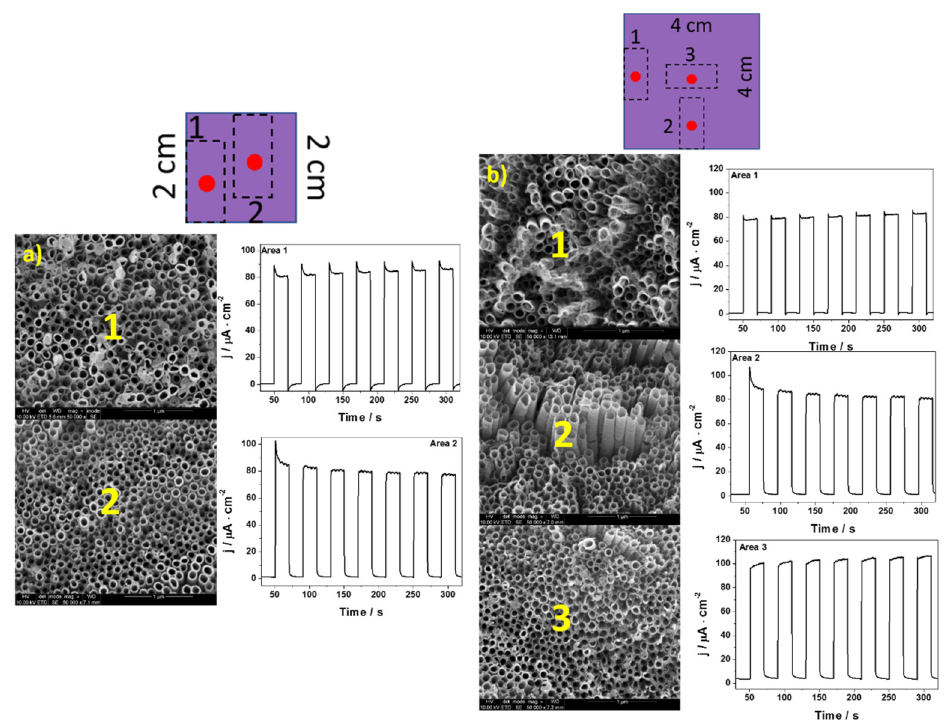
Figure 4. Transient photocurrent responses and SEM at various places on the ( a ) TN4 and ( b ) TN16.